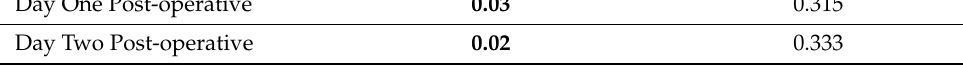
Table 6. Cont. Day One Post-operative 0.03 0.315 Day Two Post-operative 0.02 0.333